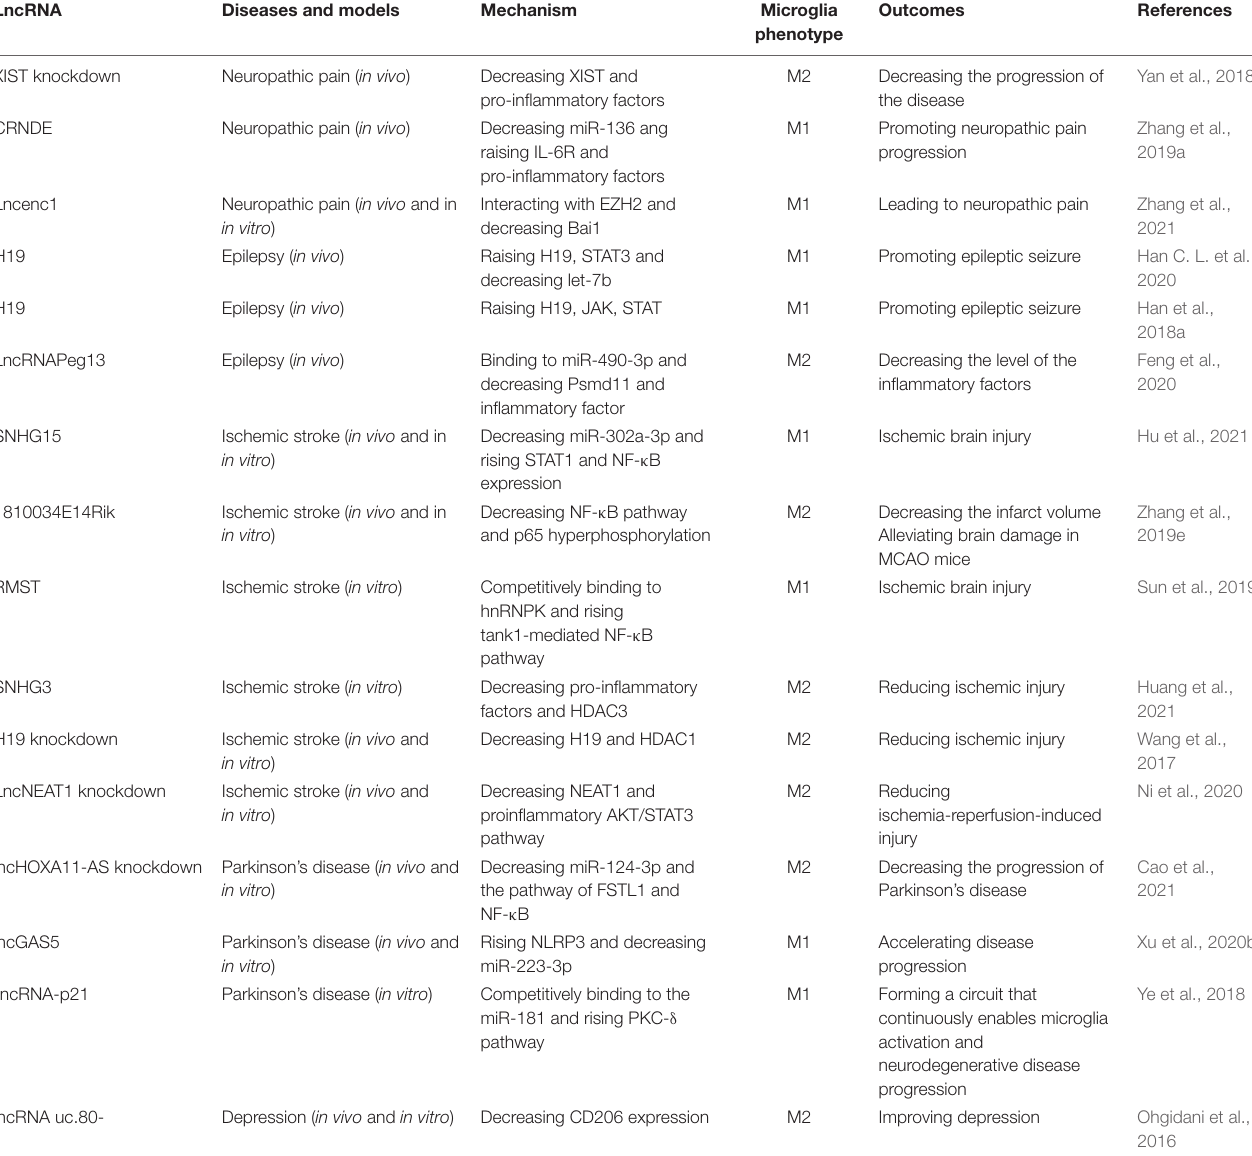
TABLE 1 | Effects of lncRNA on neurological diseases by regulating microglia